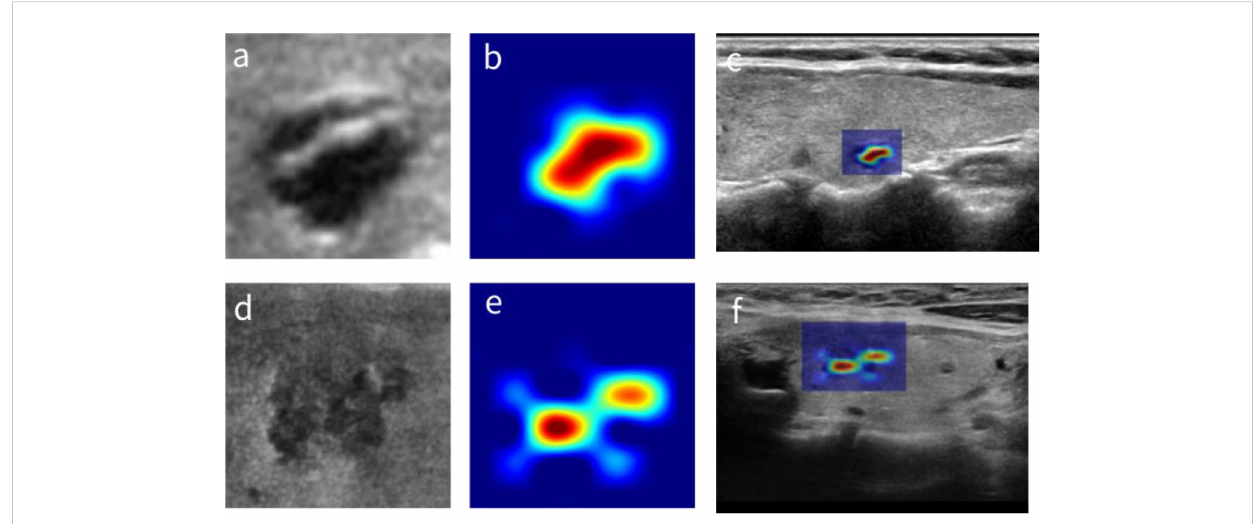
FIGURE 1 The CAMs of thyroid nodules. (A) A benign thyroid nodule. (B) The corresponding CAM. (C) The superposition of panels (A, B) in the original image. (D) A malignant thyroid nodule. (E) The corresponding CAM. (F) The superposition of panels (D, E) in the original image. CAMs, class activation